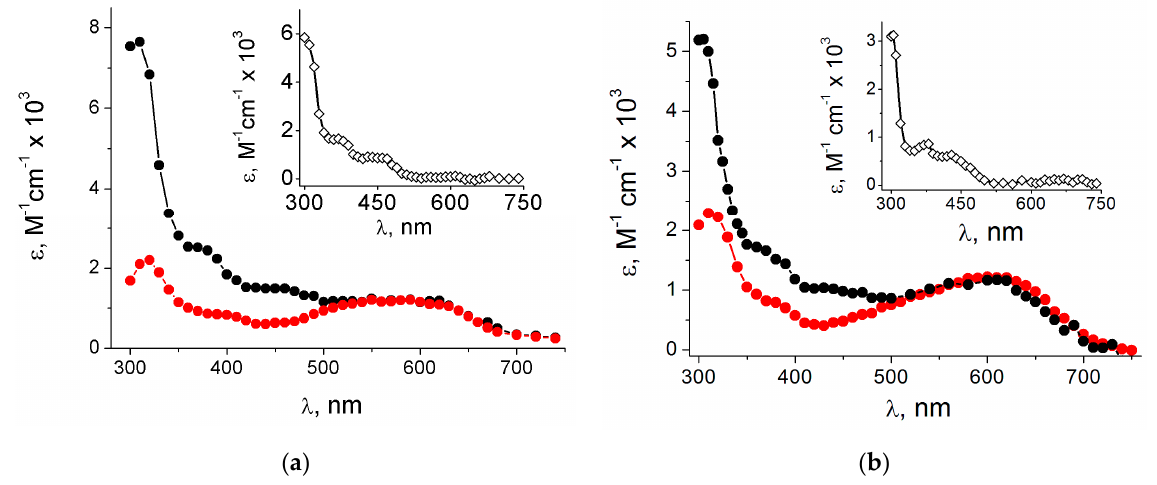
Figure 5. ( a ) Absorption spectra obtained from the reaction of HO • with Guo ( 1 ) recorded 1 μ s (black) after the pulse and 65% of the intensity of the absorption spectra obtained from the reaction of e aq − with 8-Br-Guo ( 4 ) recorded 1 μ s (red) after the pulse (inset: the spectrum resulting from the subtraction of red from black) (taken from [27]); ( b ) absorption spectra obtained from the reaction of HO • with 1-Me-Guo ( 7 ) recorded 1.2 μ s (black) after the pulse and 55% of the intensity of the absorption spectra obtained from the reaction of e aq − with 8-Br-1-Me-Guo ( 9 ) recorded 10 μ s (red) after the pulse (inset: the spectrum resulting from the subtraction of red from black) (taken from [33]).